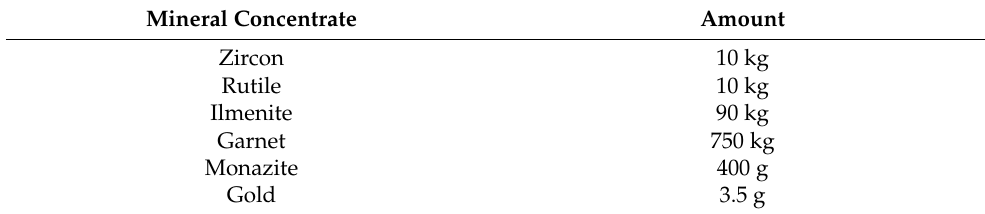
Table 9. Amount of VHM obtained during the main